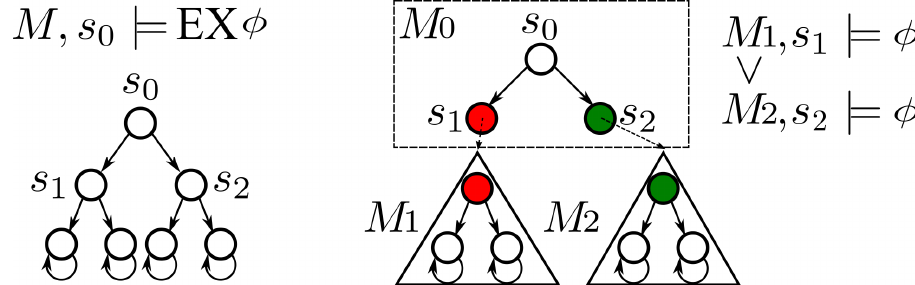
Figure 1: Distributed verification of EX φ through the parallel execution of φ in the direct